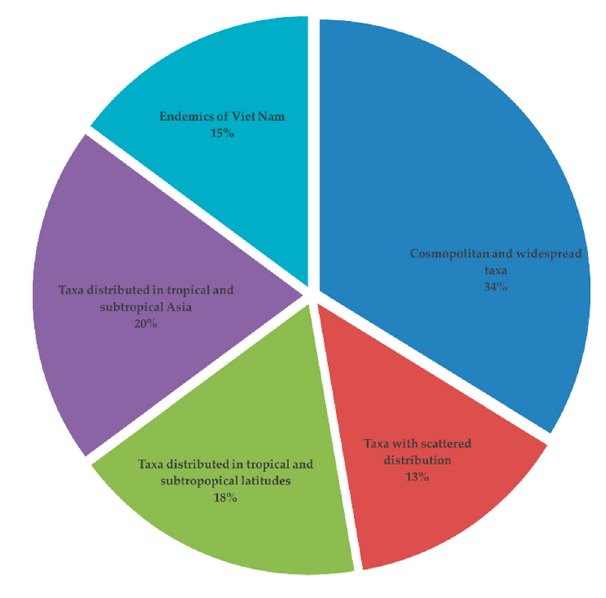
Figure 6. Diagram showing the proportions of taxa with cosmopolitan, widespread, scattered, and tropical and subtropical distributions. Cosmopolitan, widespread taxa were identified based on [1,71], other categories—on the basis of literature analysis.